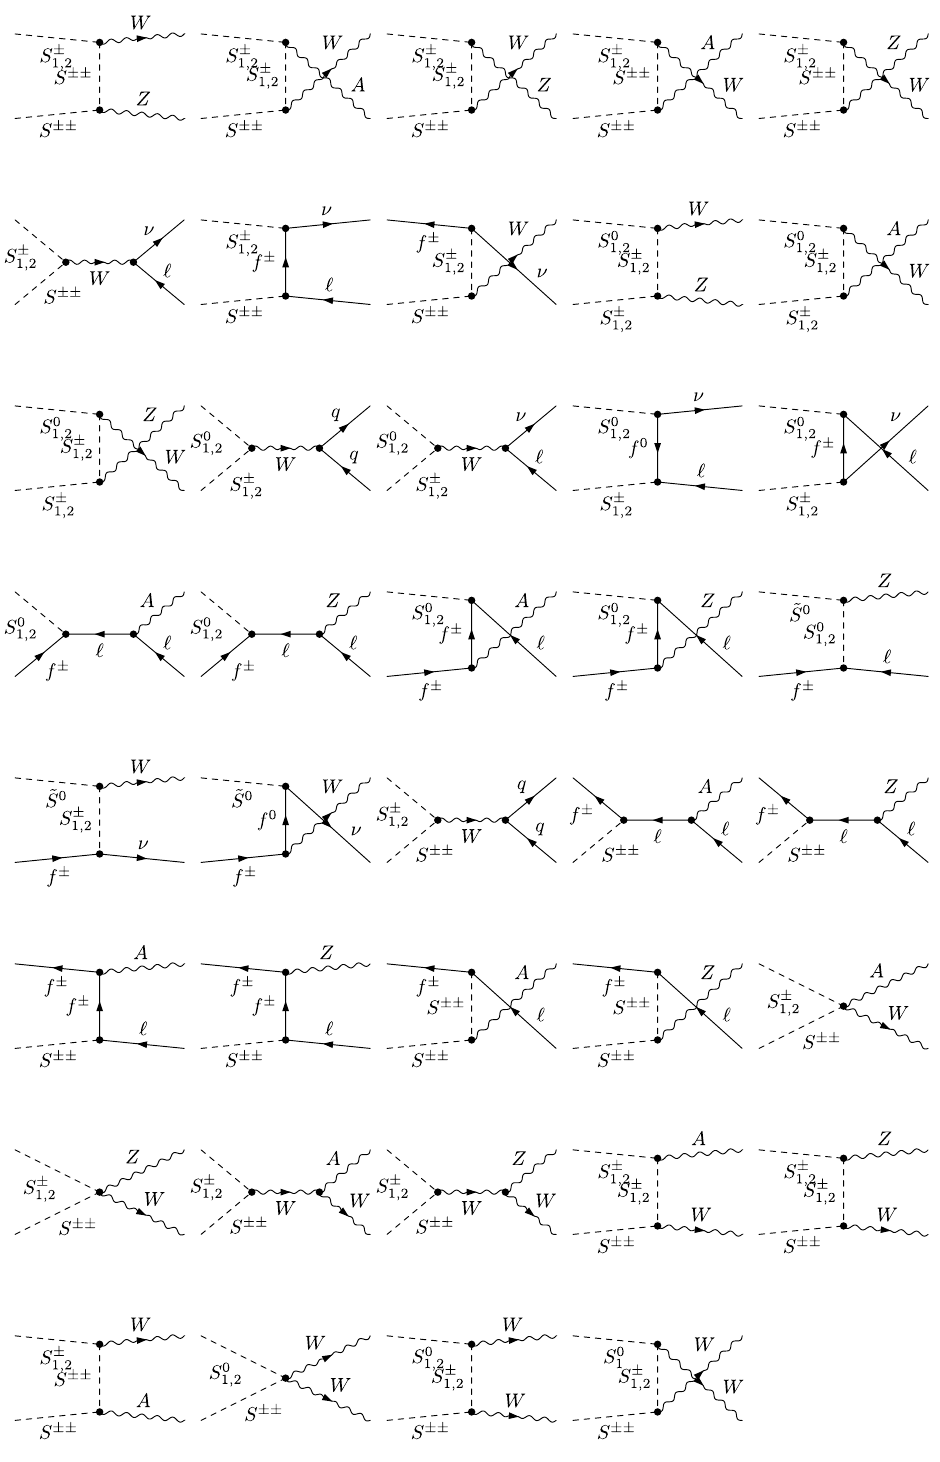
Figure 13 . Diagrams relevant for the DM production involving charged initial states ( Q = 1 , 2